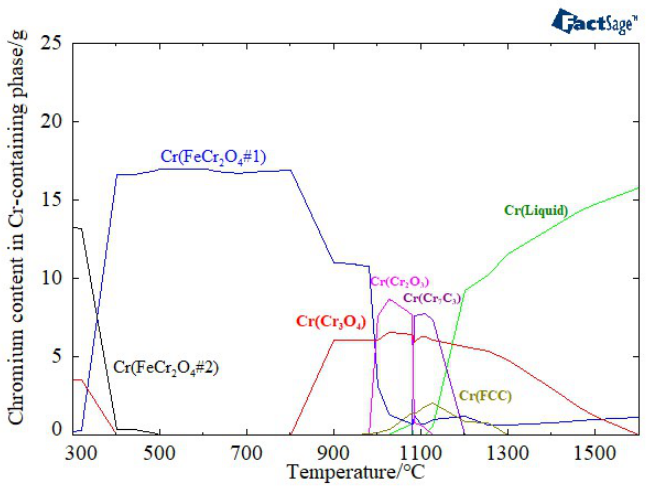
Figure 5. Occurrence of Cr element at 1 atm and different